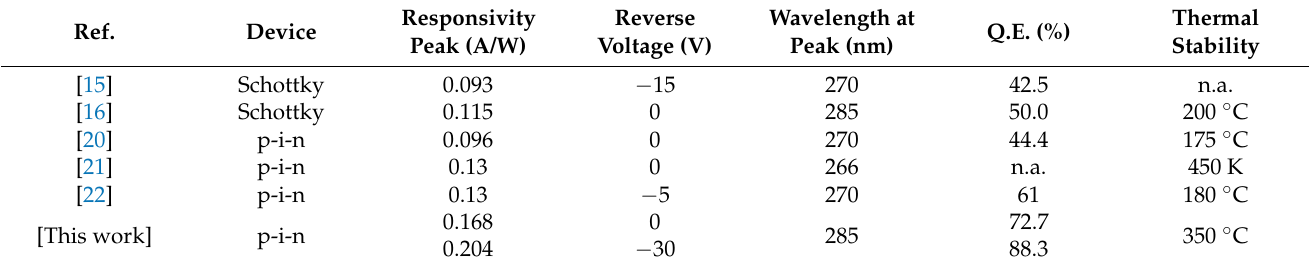
Table 1. Responsivity and Q.E. comparison for Schottky and p-i-n based UV photodiodes reported in the literature to date. Ref.